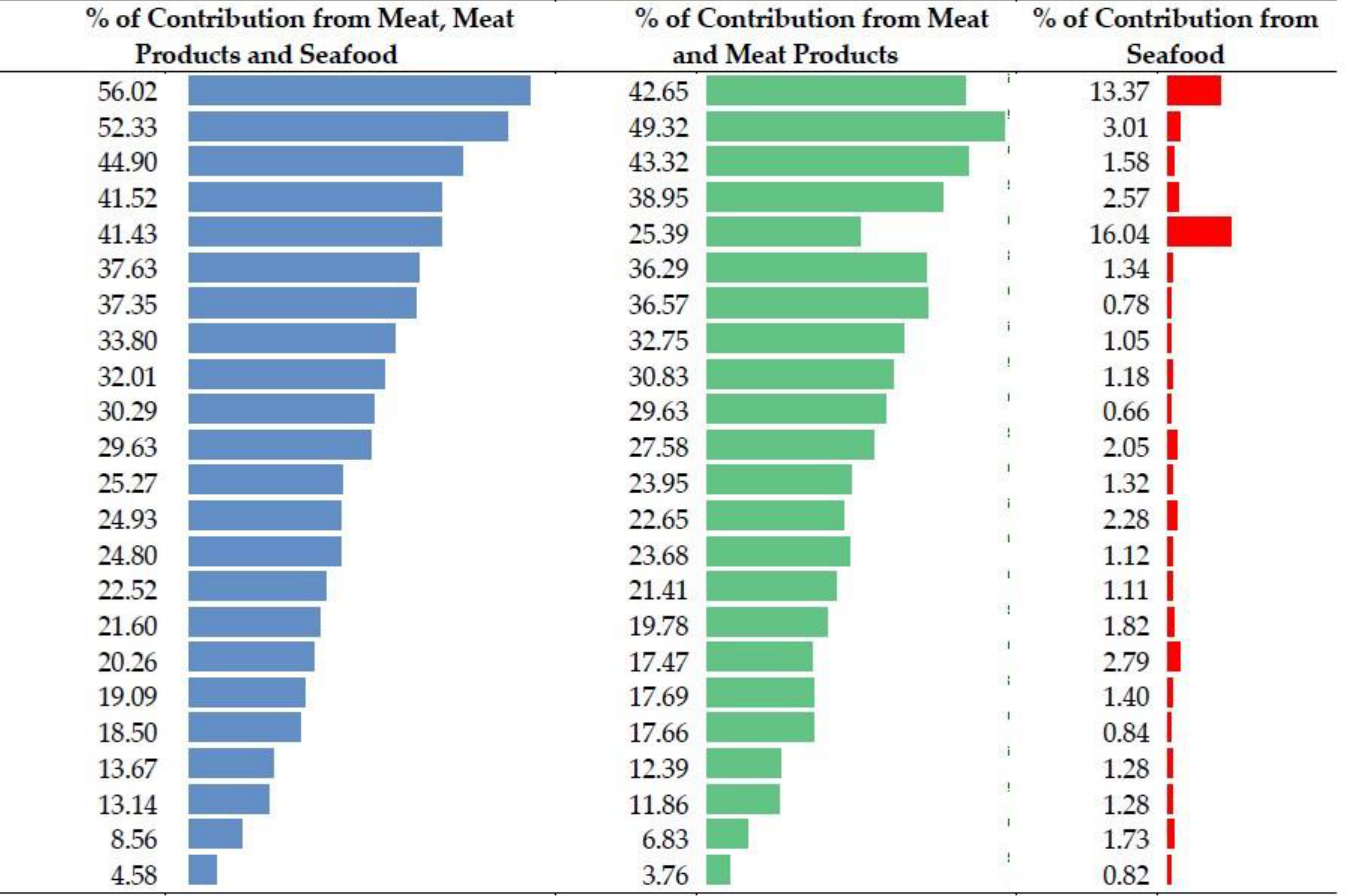
Figure 2. Summary: Meat, meat products and seafood as contributors of energy and nutrients in the average Polish diet. SFA – saturated fatty acids; MUFA – monounsaturated fatty acids; PUFA – polyunsaturated fatty acids.